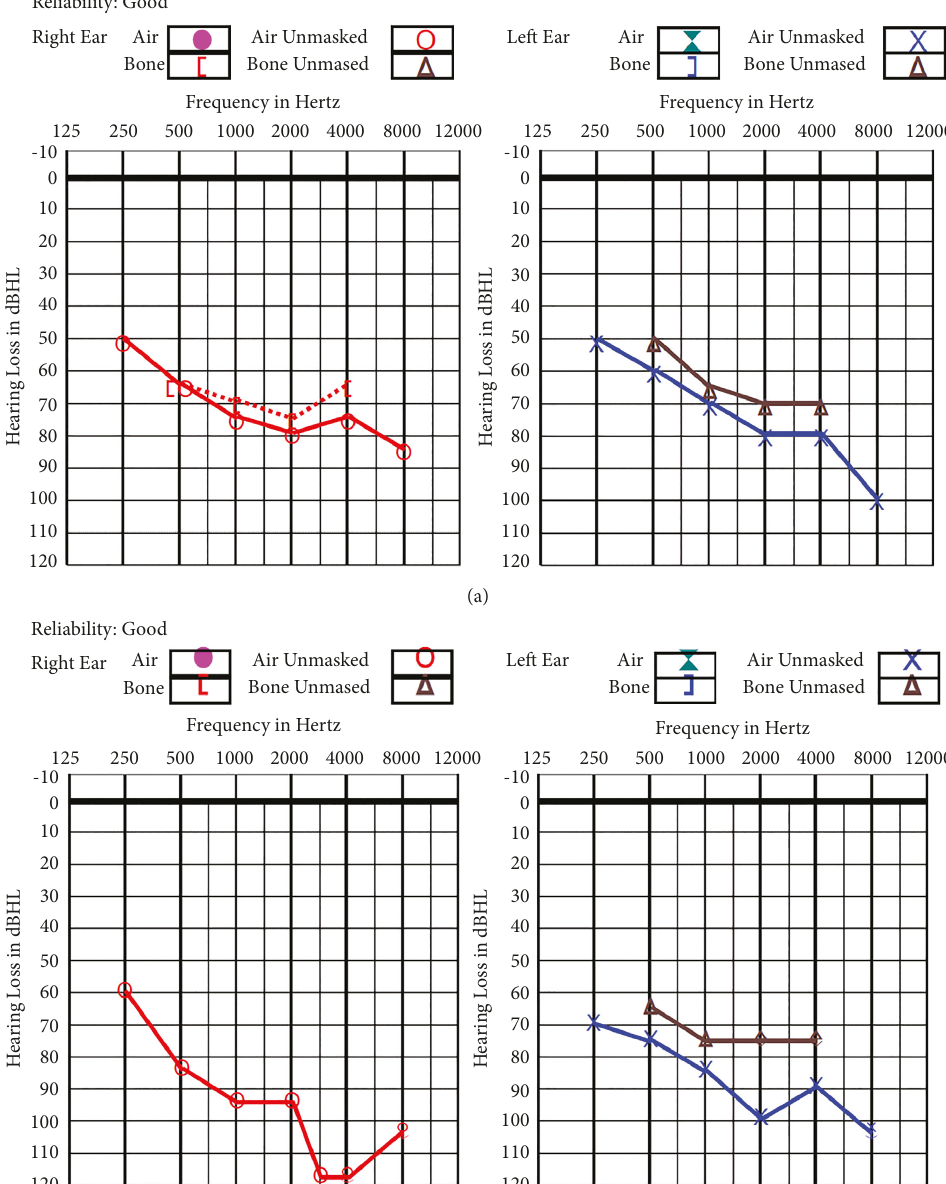
Figure 1: (a) Audiogram at presentation at 12 years of age. Bilateral severe sensorineural hearing loss. (b) Audiogram at 22 years of age. Profound sensorineural hearing loss over right ear and severe hearing loss over left